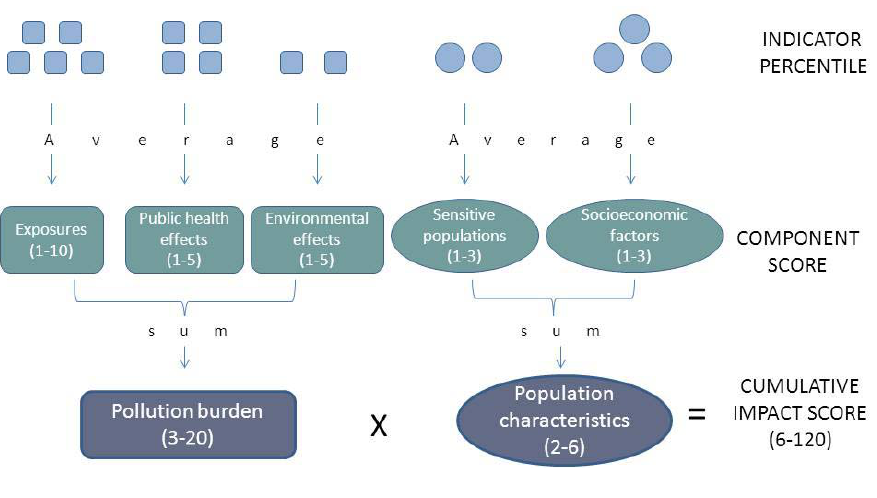
Figure 2. Structure of the cumulative impacts screening